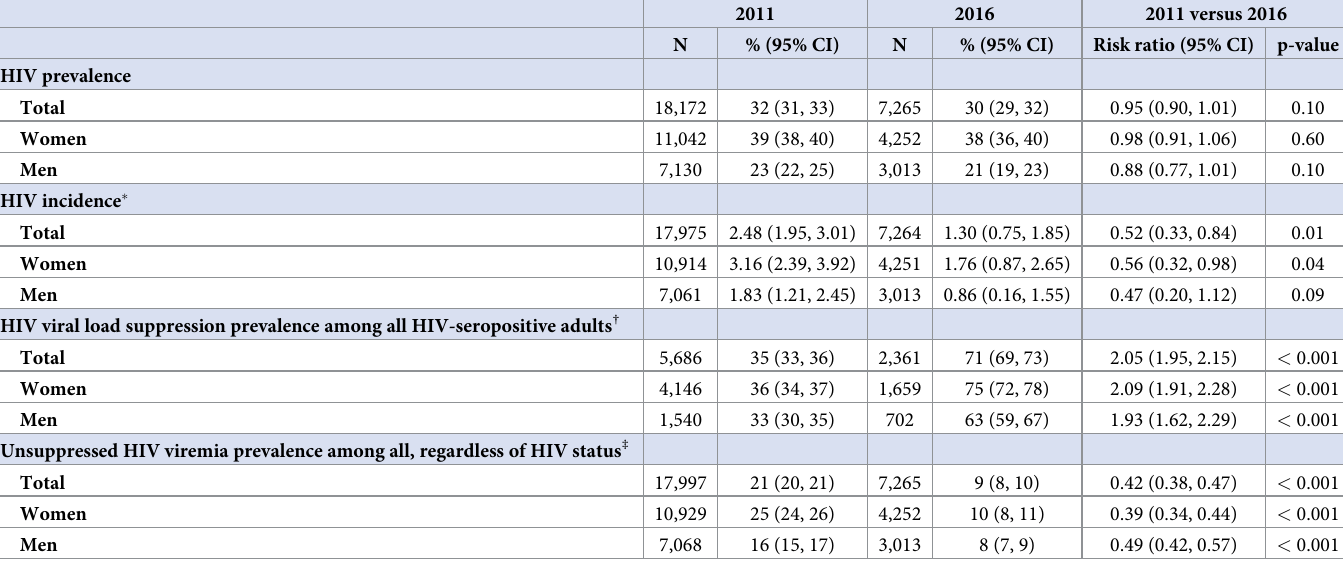
Table 2. HIV prevalence, incidence, viral load suppression, and unsuppressed viremia among adults 18–49 years in Eswatini, 2011 and